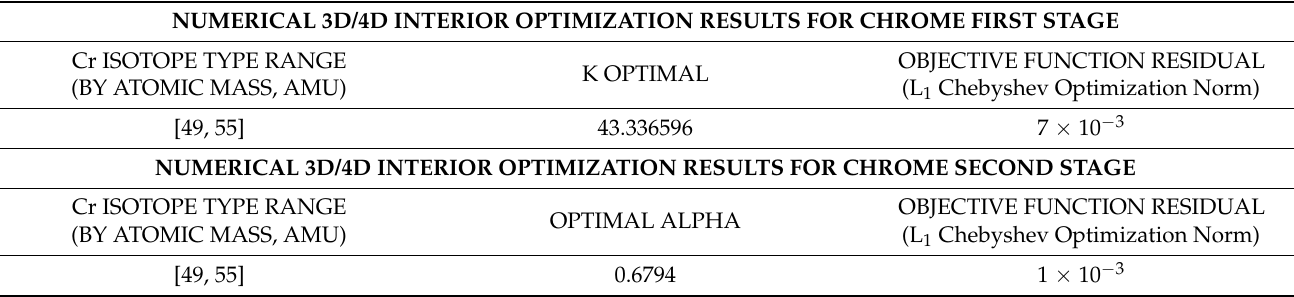
Table 3. Numerical results for Chrome using the 3D interior optimization